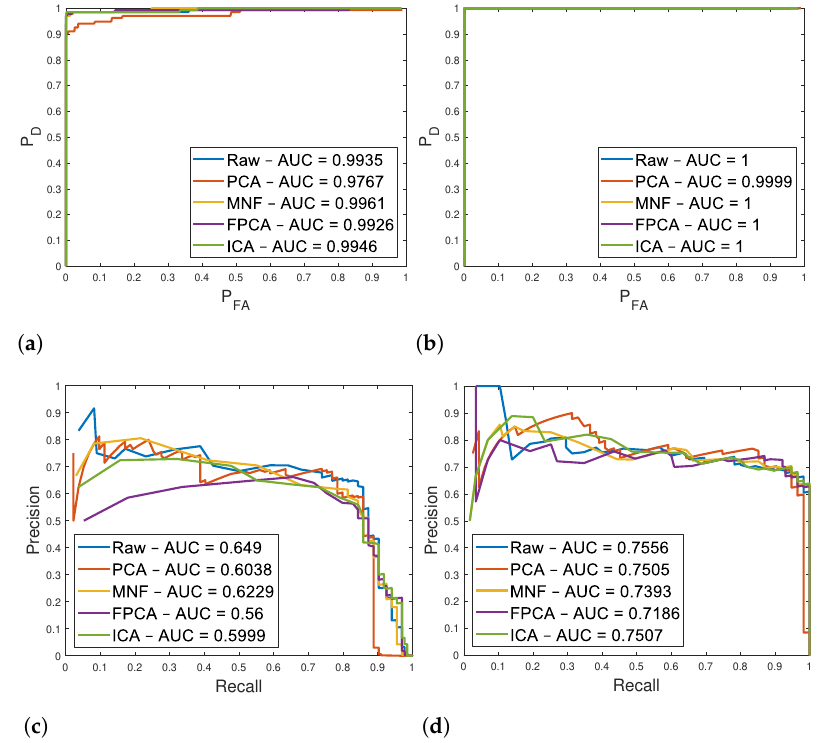
Figure 17. ROC and PR curves for detecting Target 3 (green ceramic) in the Selene dataset ( a ) ROC curve using the full spatial dimensionality data. ( b ) ROC curve using spatial DR pre-processing. ( c ) PR curve using the full spatial dimensionality data. ( d ) PR curve using spatial DR pre-processing. The average results for each target in the Selene dataset are shown in Table 7 when considering the full scene and in Table 8 when spatial DR has been applied. The average performance of the ACE detector when combined with each spatial and spectral DR method used are shown in Figure